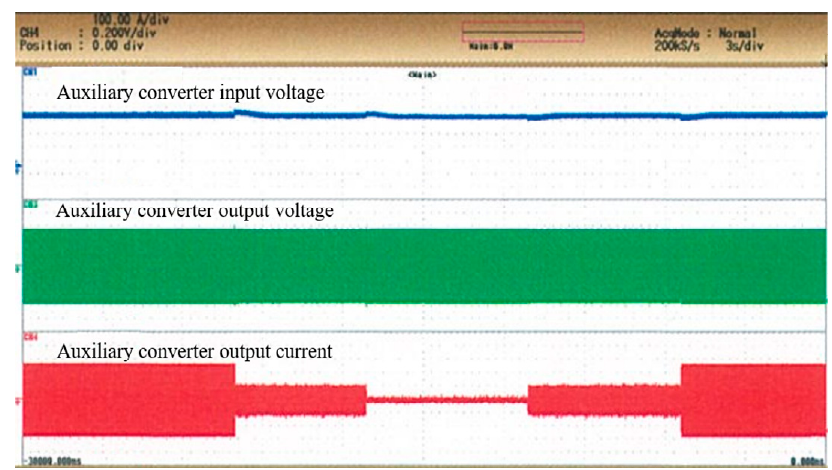
Figure 21. Bus load switching test results. Table 5. Converter output current simulation and experimental data comparison.